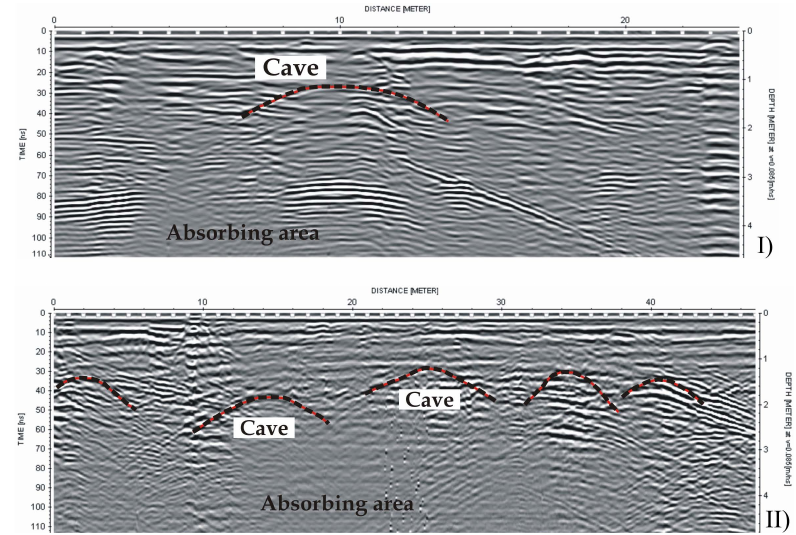
Fig. 8. Main representative radargrams carried out along Vico Goldoni (I) and M. Pagano (II) streets located at different topographic heights in Rabatana site.